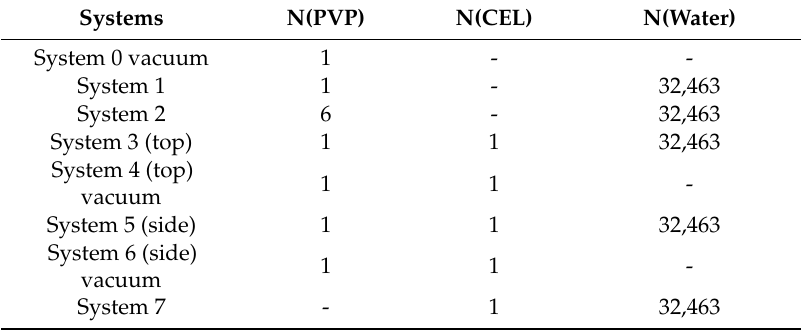
Figure 1. Atom numbering (without hydrogen atoms) in a monomer unit of polyvinylpyrrolidone (PVP) ( a ), hydrophobic surface of the cellulose fragment ( b ), hydrophilic surface of the cellulose fragment ( c ). The red spheres denote the oxygen atoms, the gray ones represent the hydrogen atoms, the cyan ones represent the carbon atoms, and the blue sphere represents the nitrogen atom. Table 1. Details of di ff erent systems: number of PVP, cellulose fragment (CEL) and water